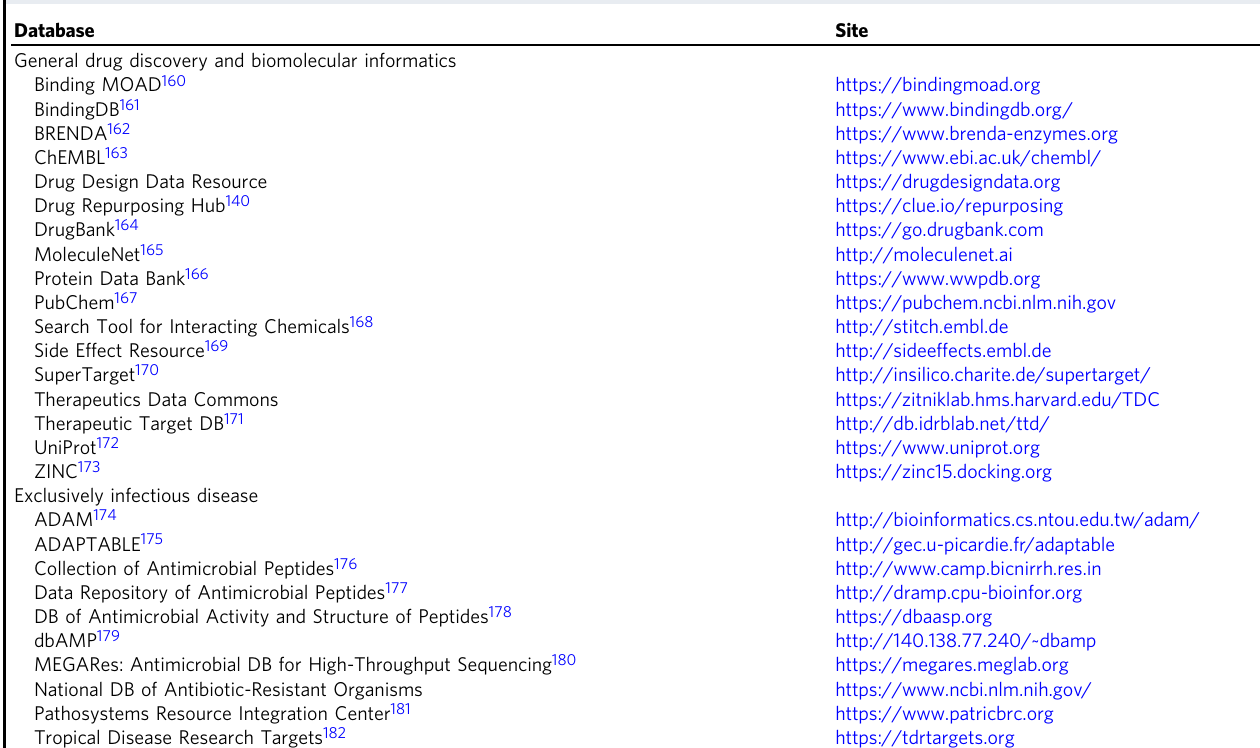
Table 1 Databases for computational antibiotic